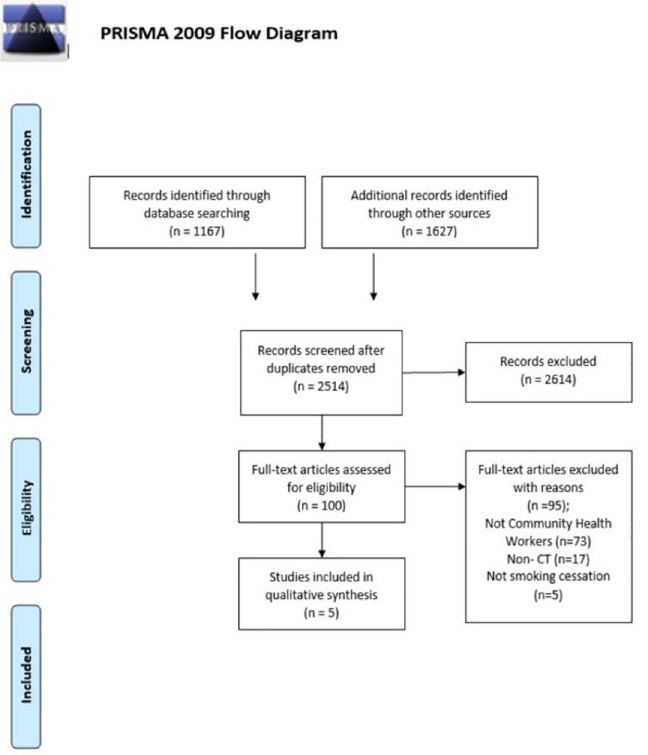
Fig 1. PRISMA flowchart for the selection of studies. Outcomes of the systematic review of the literature by record identification, screening, and analysis in the Preferred Reporting Items for Systematic Reviews and Meta-Analyses (PRISMA) statement flow